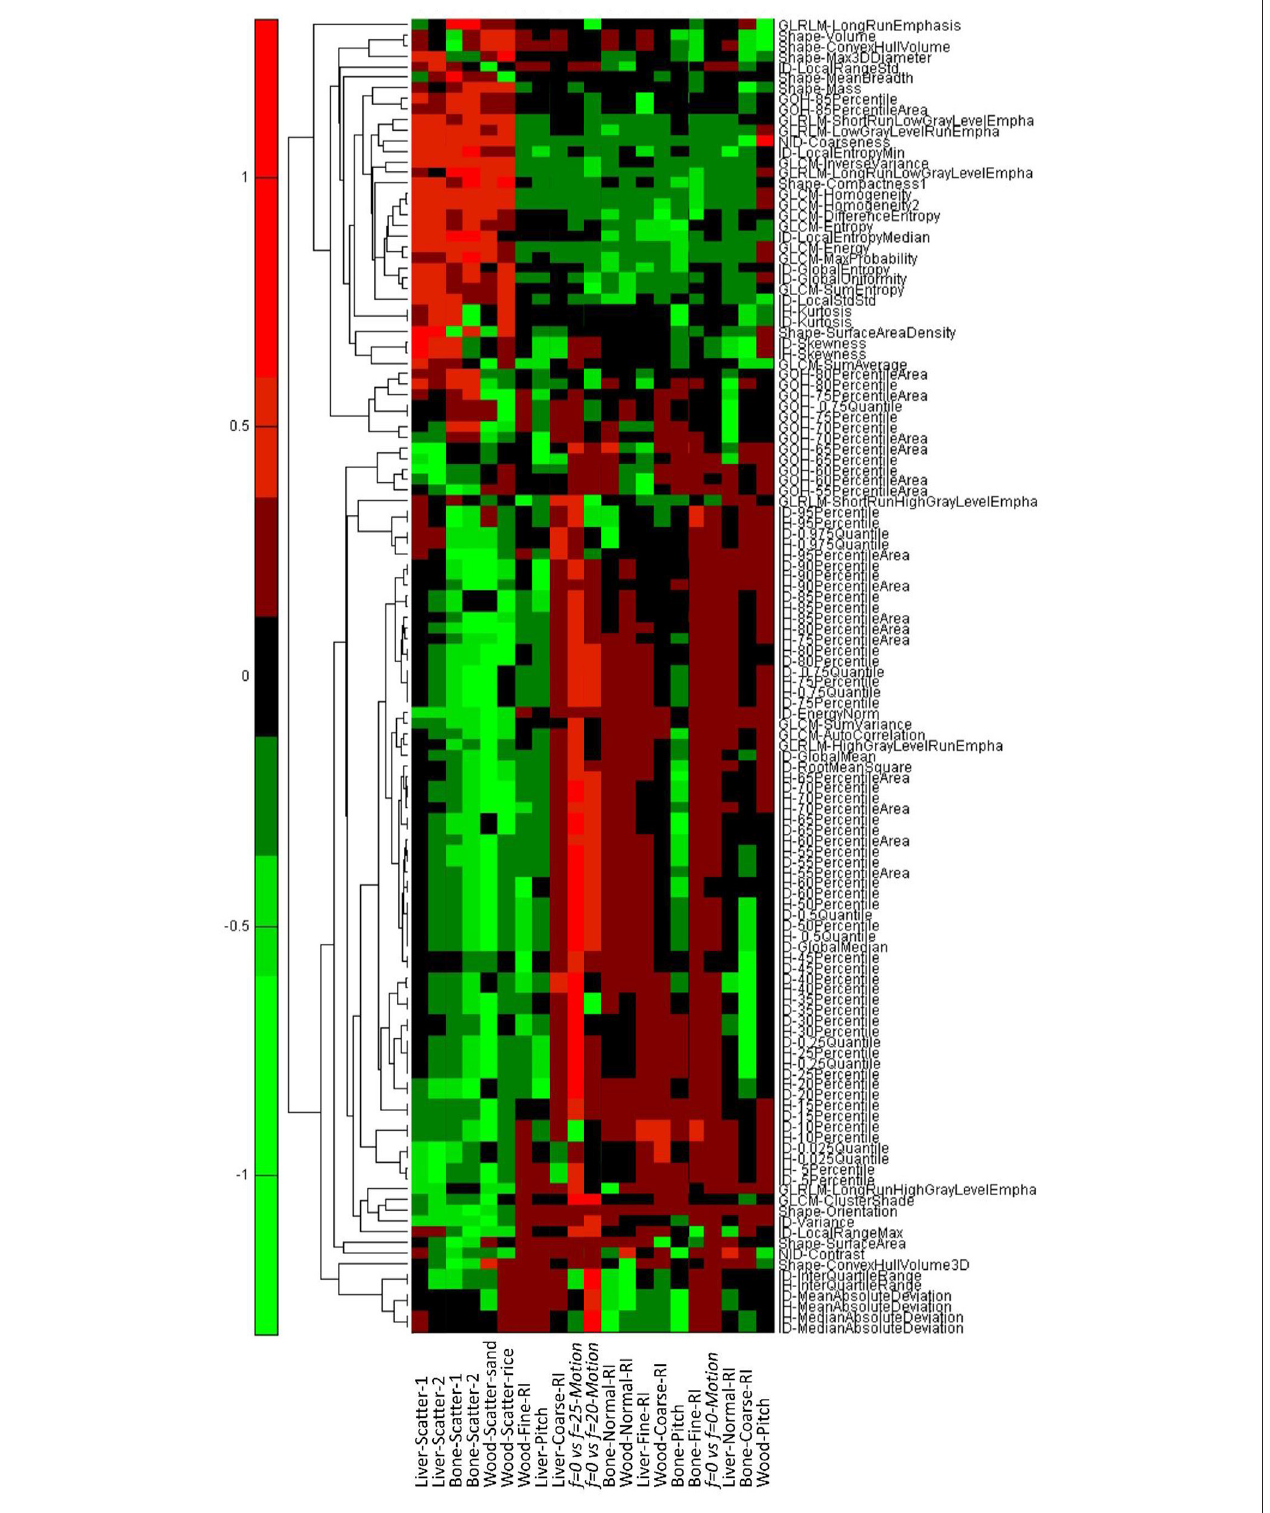
FIGURE 7 | The results for the scatter, AcP, RI, and motion tests. Negative values imply the difference in the phantom measurements is less than the mean intrapatient difference and thus a “pass.” Positive values imply that the phantom difference was larger than the mean intrapatient difference, and the feature failed the test. Scatter1 indicates tissues surrounded with one layer of solid water, and scatter2 indicates tissues surrounded with two layers of solid water.